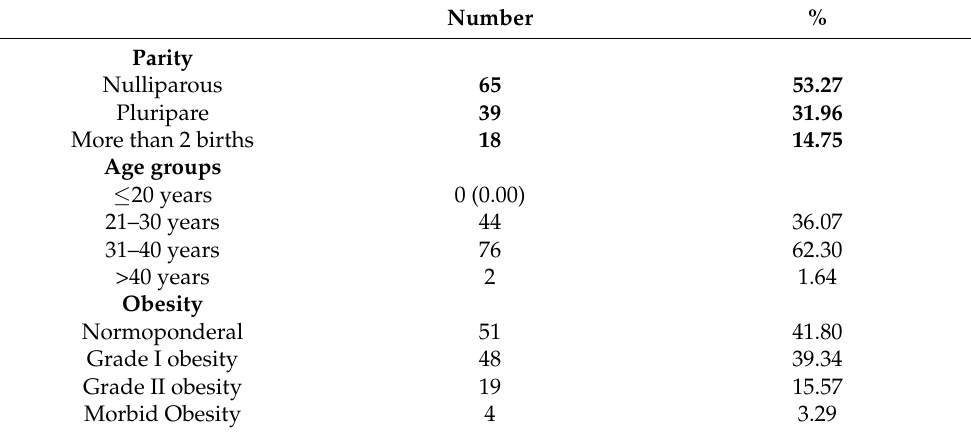
Table 2. Maternal characteristics of the GDM group.